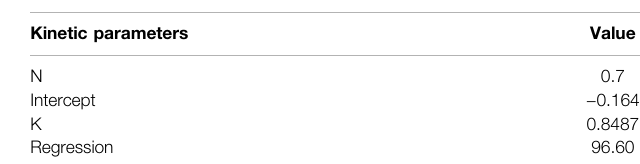
TABLE 3 | Kinetic parameters of accumulative drug release of benzocaine from